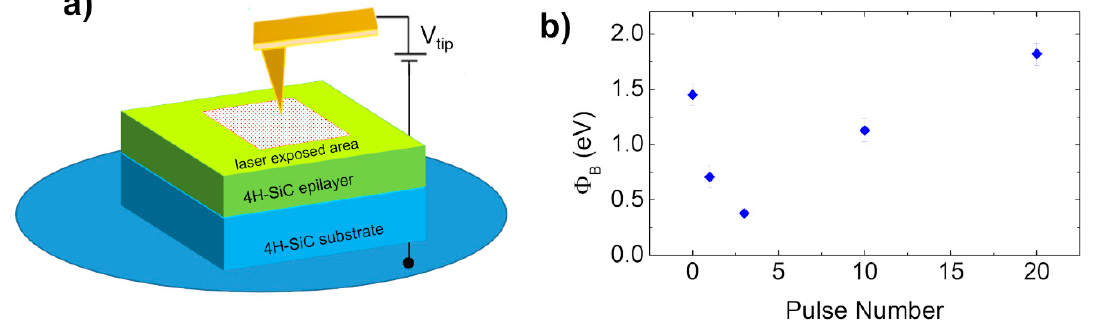
Figure 14. Nanoscale current–voltage characterization (by PeakForce TUNA mode of AFM) of Au/4H-SiC contact to laser-irradiated semiconductor surface: ( a ) scheme of the nanoscale current– voltage measurement set-up; ( b ) Schottky barrier height values extrapolated by I–V analysis for 4H-SiC surface irradiated with different pulse numbers. Figure adapted with permission from Ref. [95]. Copyright 2021 Elsevier